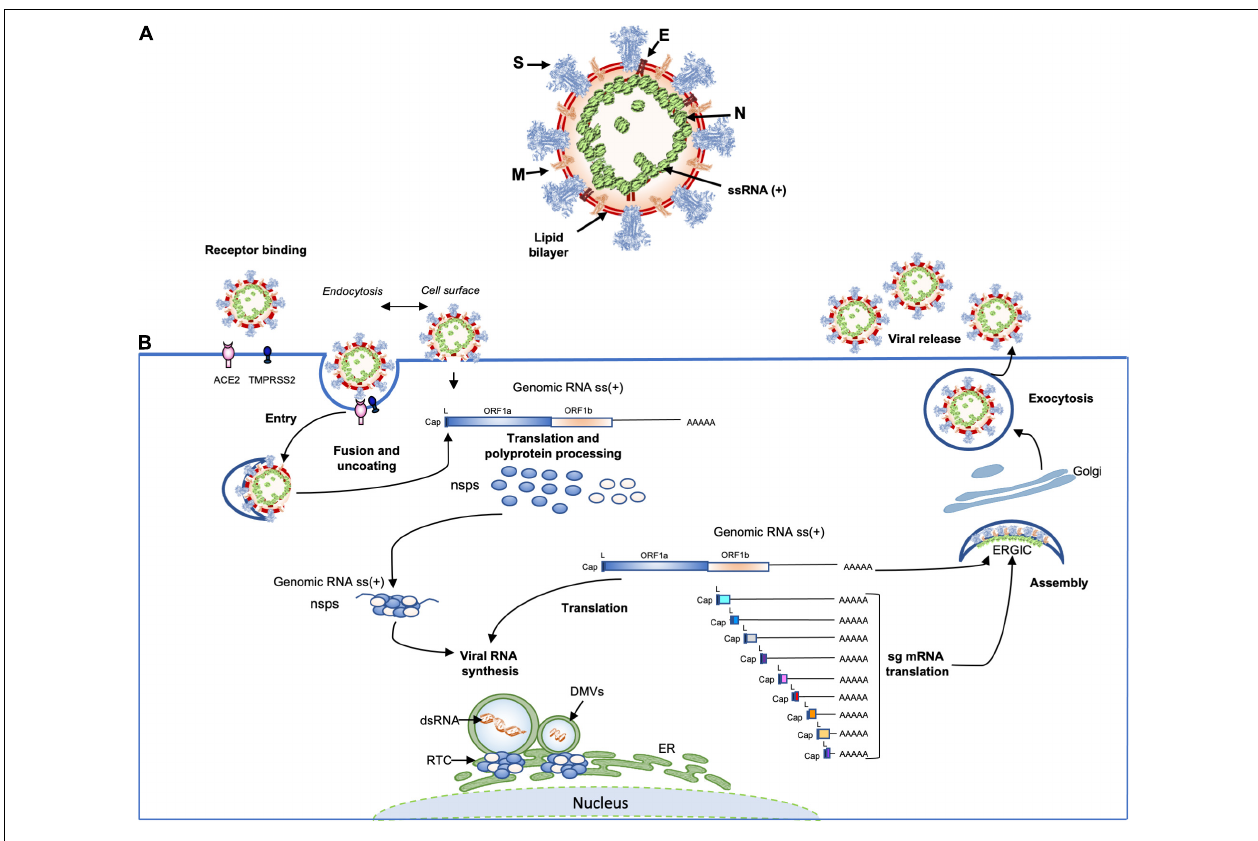
FIGURE 3 | (A) Schematic representation of the SARS-CoV-2 virus structure. Together with membrane (M), envelope (E) transmembrane proteins, the spike (S) glycoprotein projects from a host cell-derived lipid bilayer. The positive-sense viral genomic RNA is associated with the nucleocapsid proteins forming the ribonucleoprotein (Mandala et al., 2020; Yao et al., 2020; Zhao et al., 2020). (B) The coronavirus life cycle. The coronavirus binds to the specific receptor (for SARS-CoV-2 the ACE2) together with the host factor TMPRSS2. Following entry, from the viral genomic RNA a translation of the two large open reading frames (ORF1a and ORF1b) occur. The resulting polyproteins are processed into individual non-structural proteins (16nsps) that form the replication and transcription complex (RTC). Formation of nuclear double membrane spherules (DMVs) associated with RTC allows viral genomic RNA replication and transcription of subgenomic mRNAs (sg mRNA). Produced structural proteins translocate into endoplasmic reticulum (ER) membranes and transit through the ER to the Golgi intermediate compartment (ERGIC) where nucleocapsid proteins (N) interact with newly produced genomic RNA resulting in the budding into the lumen of vesicular compartments. Finally, virions are secreted by exocytosis from the infected